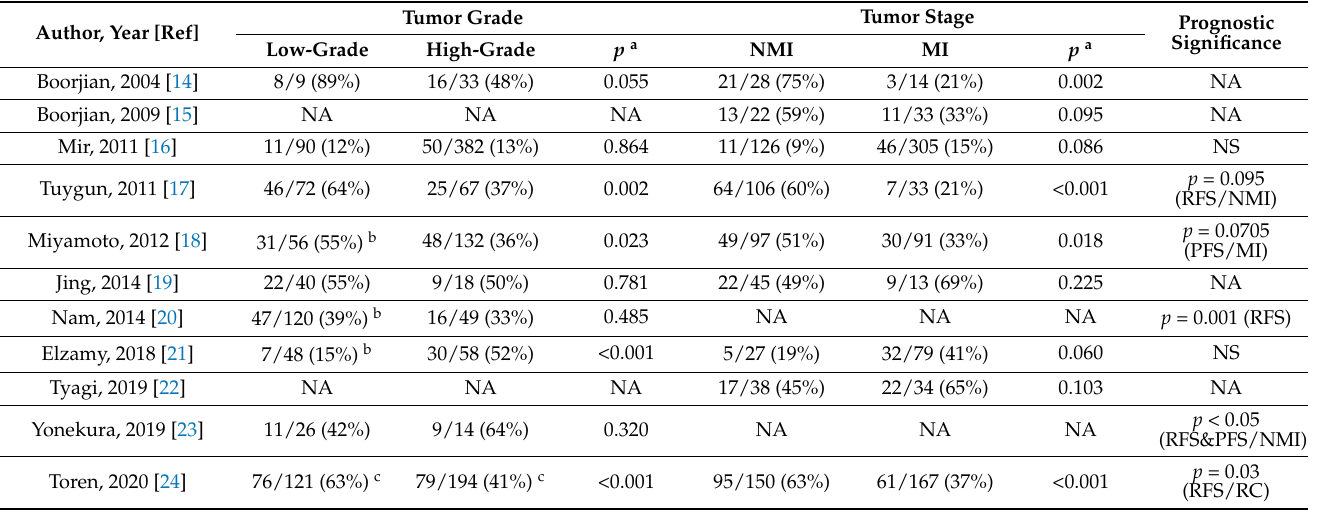
Table 1. Immunoreactivity for AR in low-grade vs. high-grade and NMI vs. MI bladder cancers and its prognostic significance.